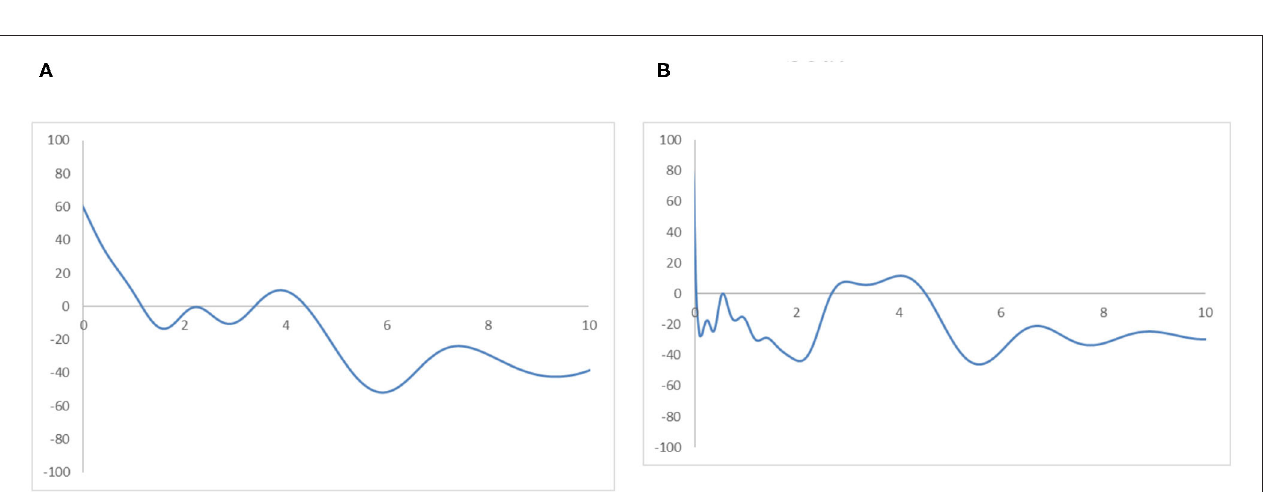
FIGURE 8 | Mobility probability plot (MPP) for the RIVAPC of countries for the Global North and the Global South. Source: authors’ calculation. N.B. The vertical axis indicates net upward mobility (%) and the horizontal axis indicates RIVAPC values. (A) Global North. (B) Global